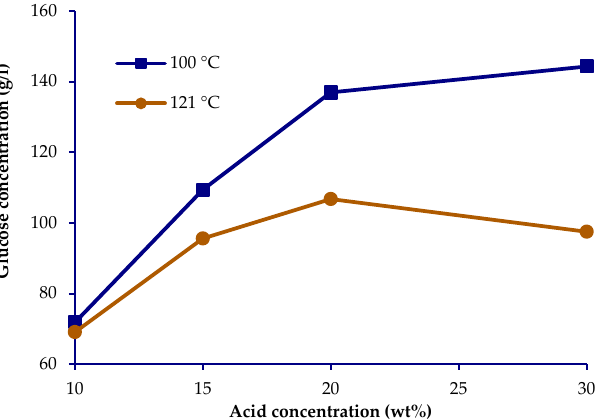
Figure 4. Glucose concentration in the liquid product at different combinations of sulfuric acid concentration and temperature in the post-hydrolysis step. The values are adjusted assuming all loss of mass during filtration was evaporated water.